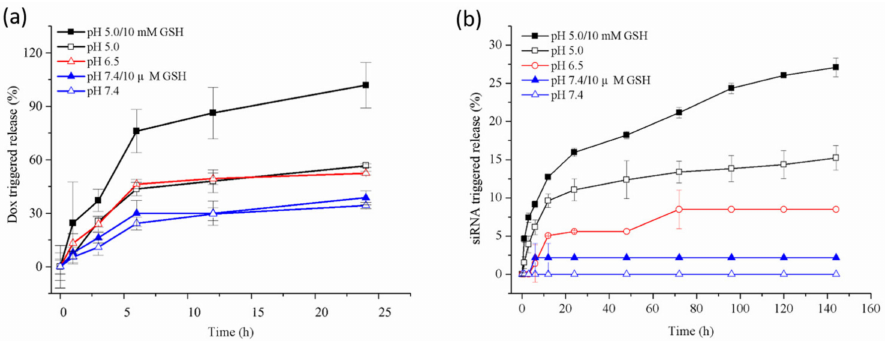
Figure 4. In vitro pH/redox stimuli release profiles from ( a ) NOCC/Dox/HA-SH and ( b ) SH-HA-